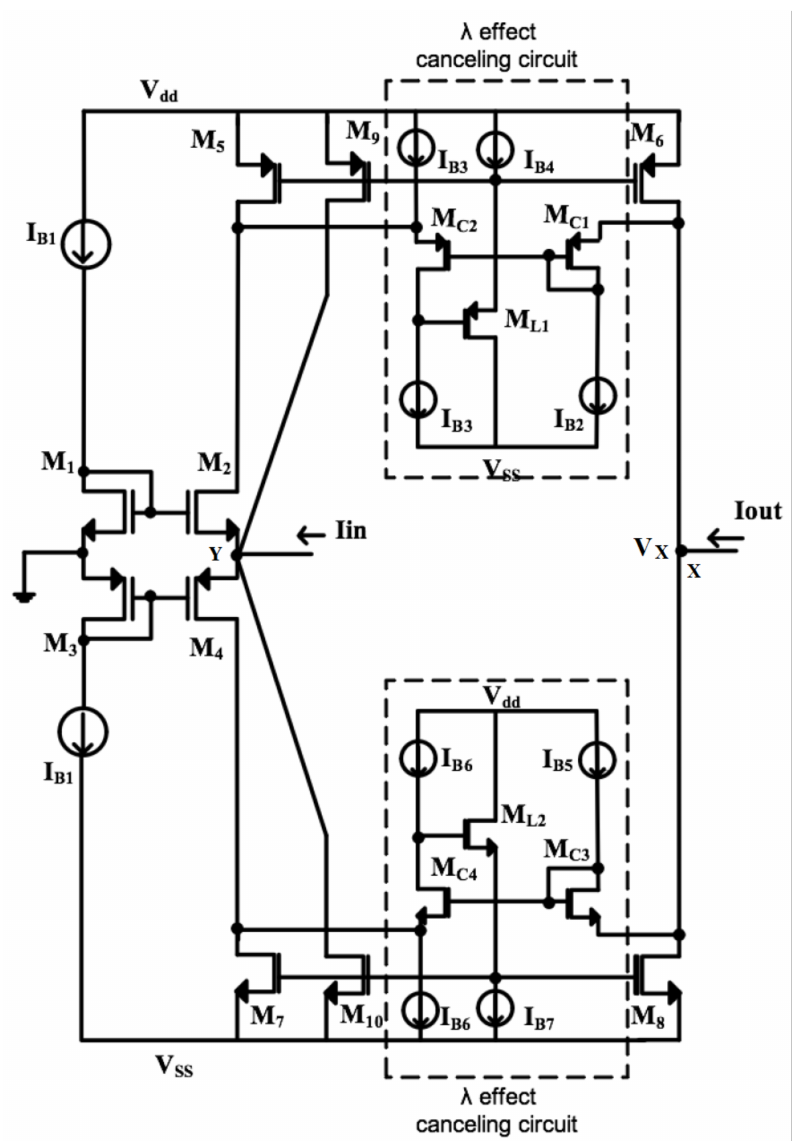
Figure 3. Proposed high drive class AB